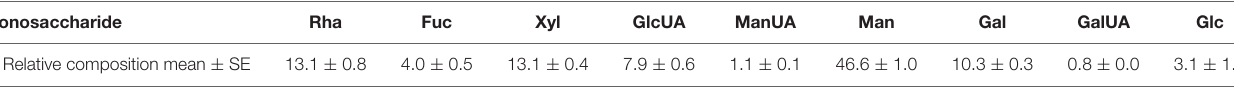
TABLE 1 | Monosaccharide composition of an alcohol insoluble fraction (AIR) isolated from P. tricornutum cells. Monosaccharide Rha Fuc Xyl GlcUA ManUA Man Gal GalUA Glc % Relative composition mean ± SE Results are expressed in relative percentage (%). Values are the means of monosaccharide quantities determined in triplicate by GC-FID analysis performed on AIR isolated from four independent cell cultures. Rha, rhamnose; Fuc, fucose; Xyl, xylose; GlcUA, glucuronic acid; ManUA, mannuronic acid; Man, mannose; Gal, galactose; GalUA, galacturonic acid; Glc,